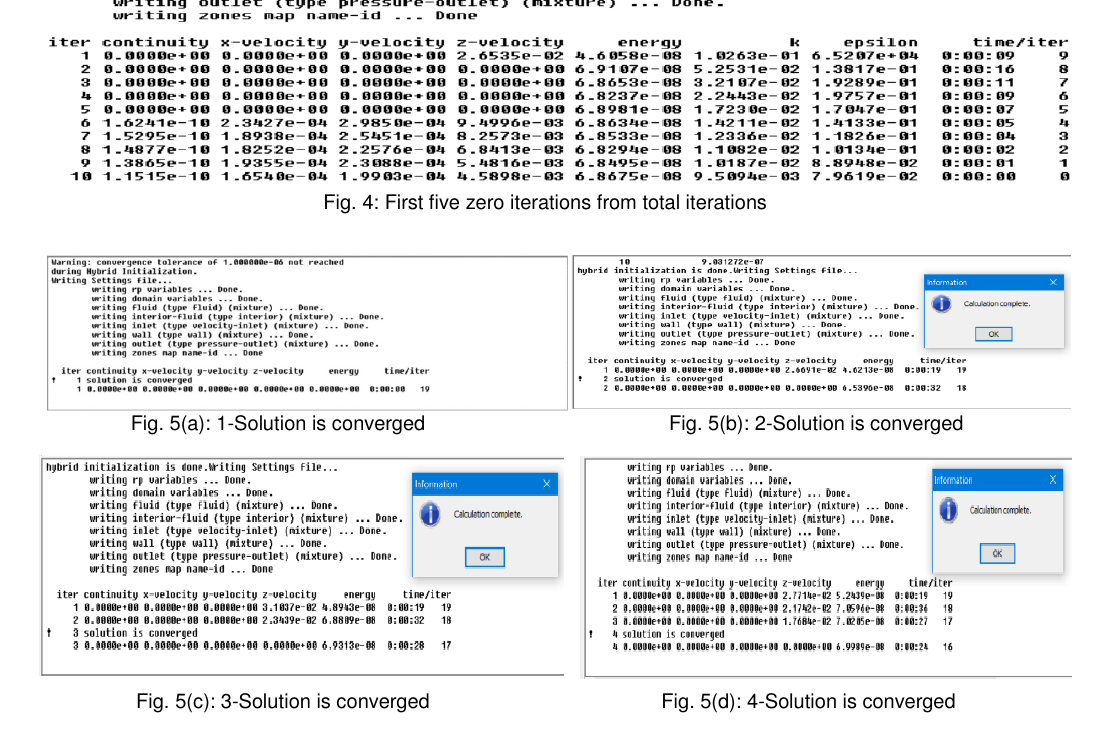
Fig. 5(c): 3-Solution is converged Fig. 5(d): 4-Solution is